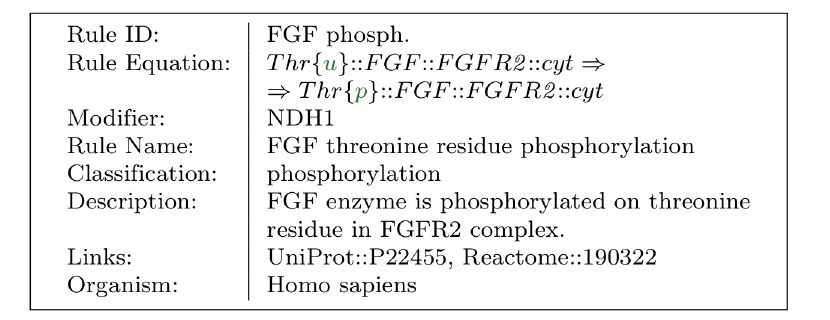
Fig 3. A rule employing agent state change. A threonine ( Thr ) amino acid residue of a FGF protein inside a FGFR2 complex can change its state from unphosphorylated u to phosphorylated p .